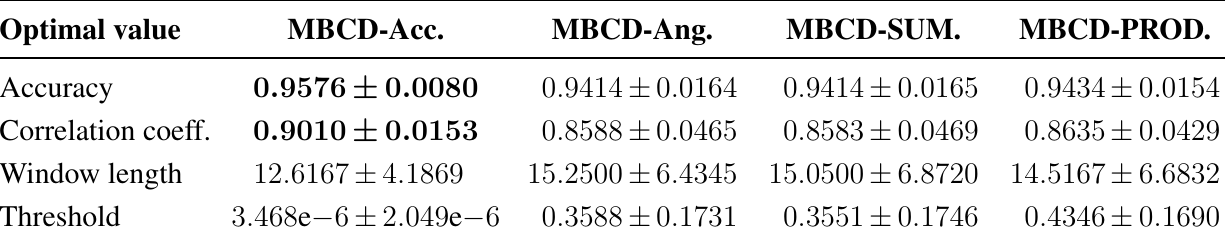
Table 11. Algorithms applied to real signals. Average Accuracy, Correlation coefficient and associated parameters (Memory Based CUSUM Detector).